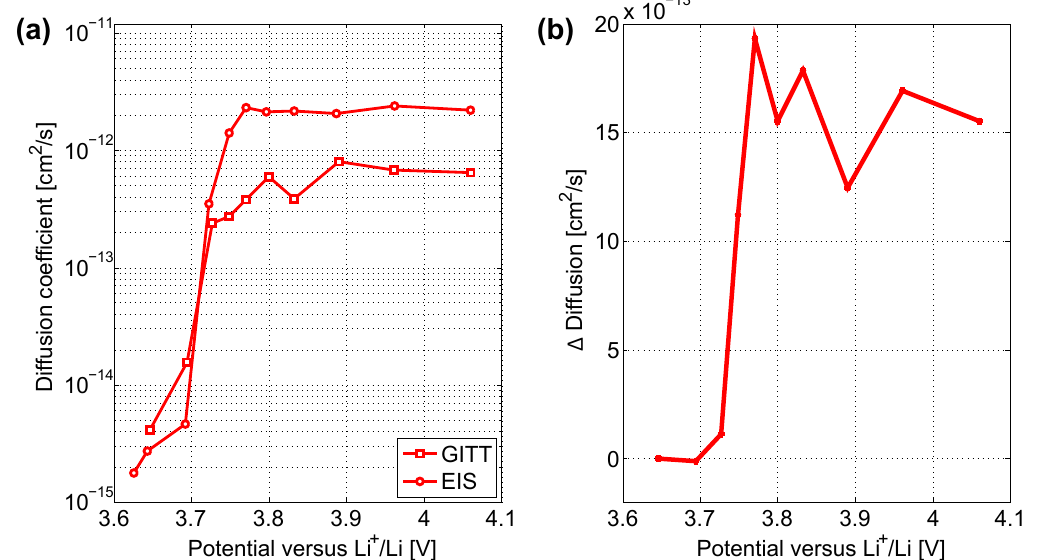
Figure 11. ( a ) Diffusion coefficients in cycled electrodes from GITT and EIS characterisations. ( b ) Difference between the two characterisation techniques.